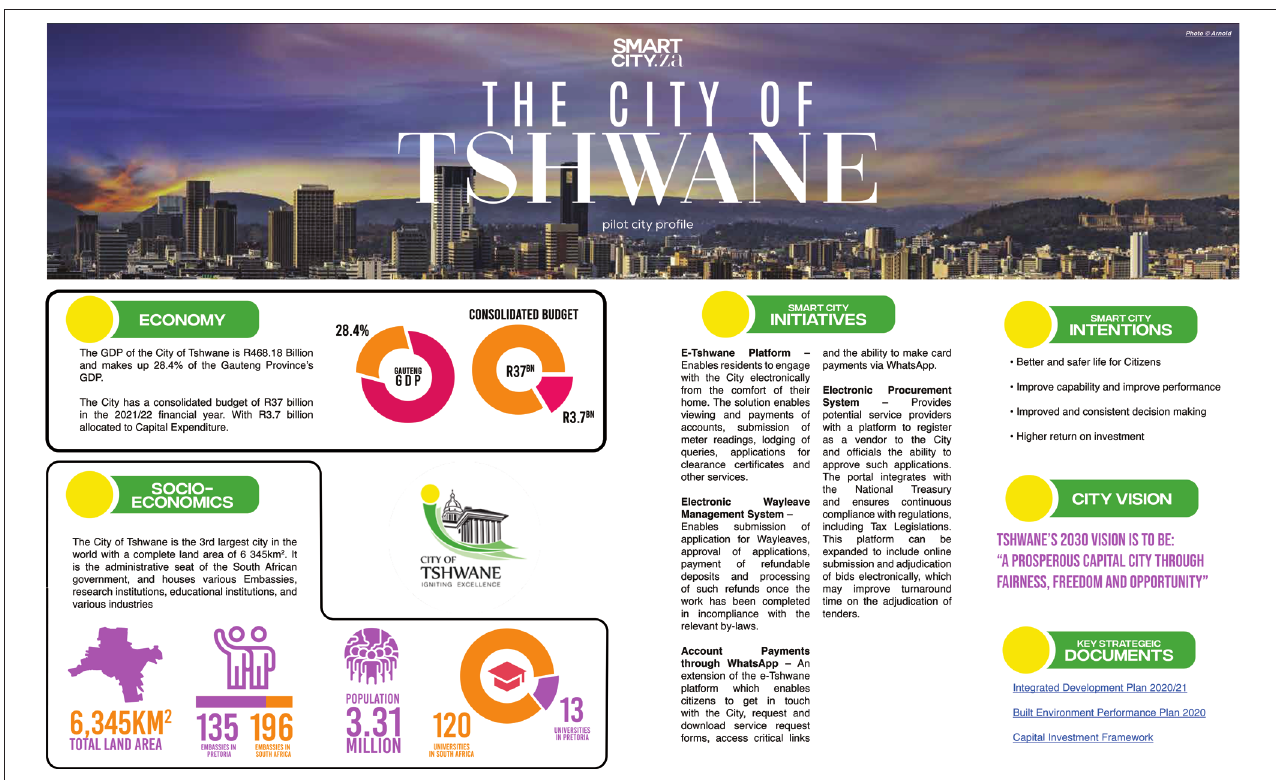
FIGURE 3: The City of Tshwane e-municipality.